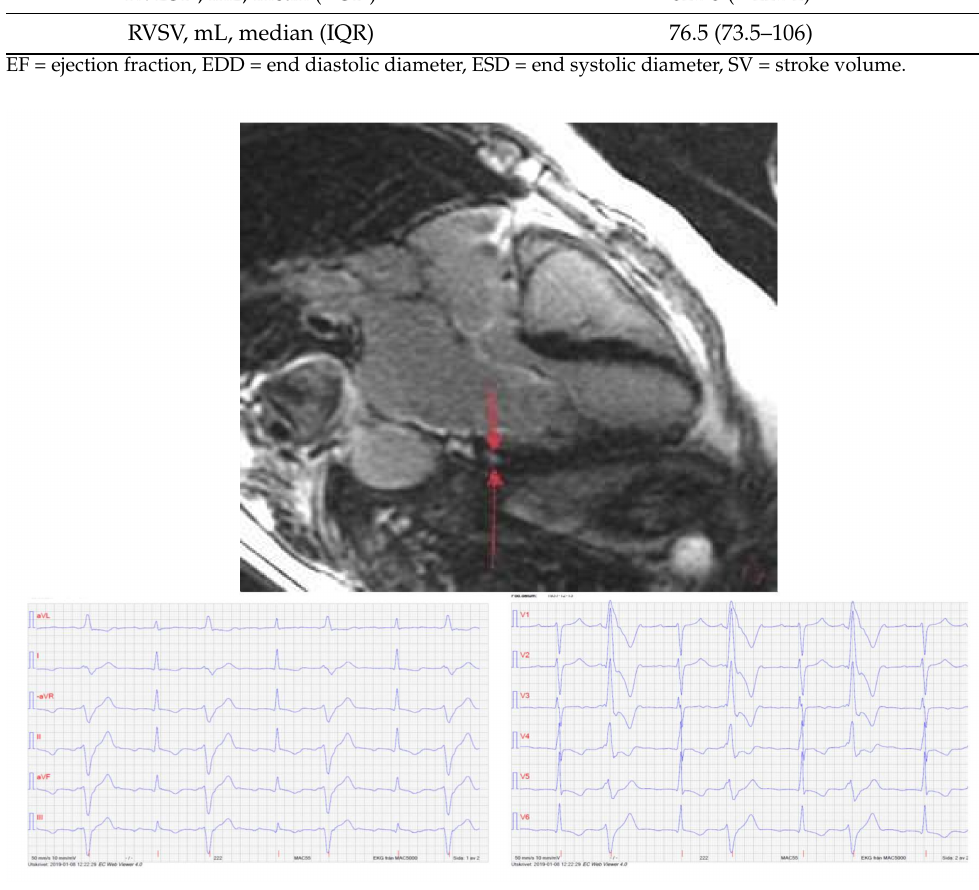
Figure 3. CMR image showing fibrosis in the basal inferolateral area of the left ventricle. Below: ECG from the same patient, showing frequent PVCs with a morphology corresponding to the fibrotic area, which is likely to act as site of